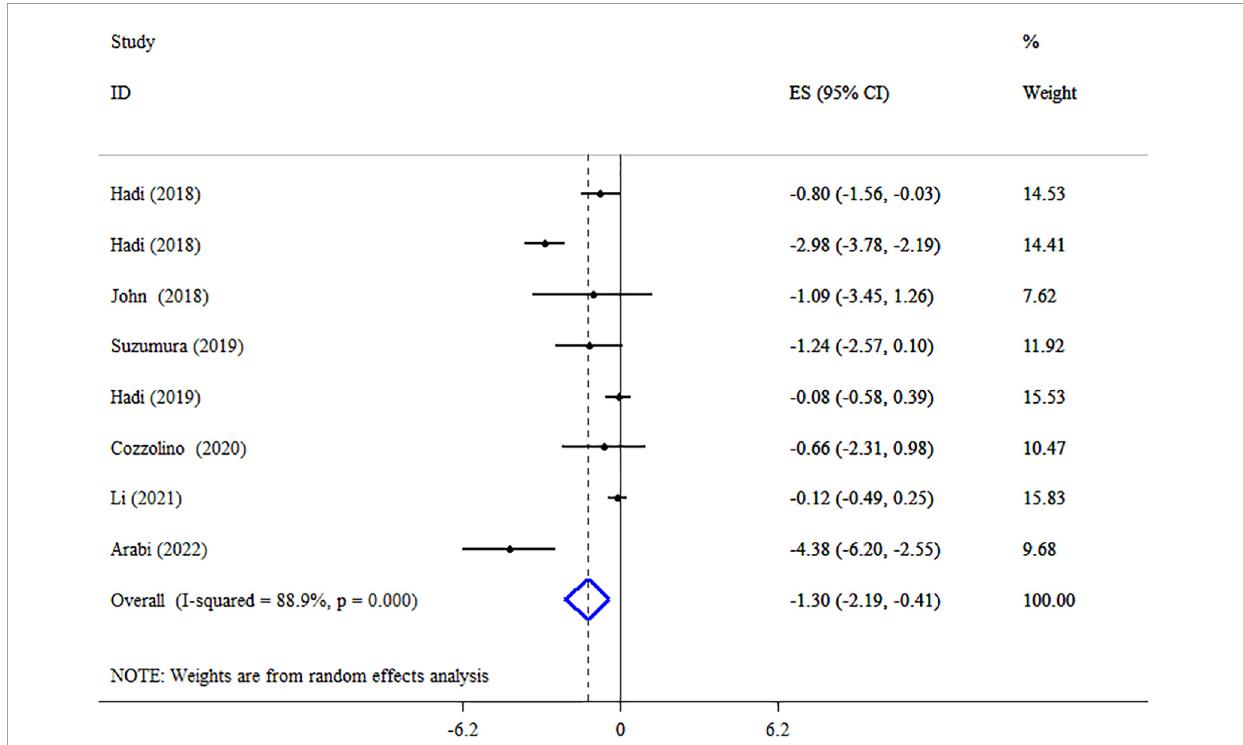
FIGURE3 Forest plot detailing mean difference and 95% confidence intervals (CIs), the impacts of synbiotic supplementation on body weight.